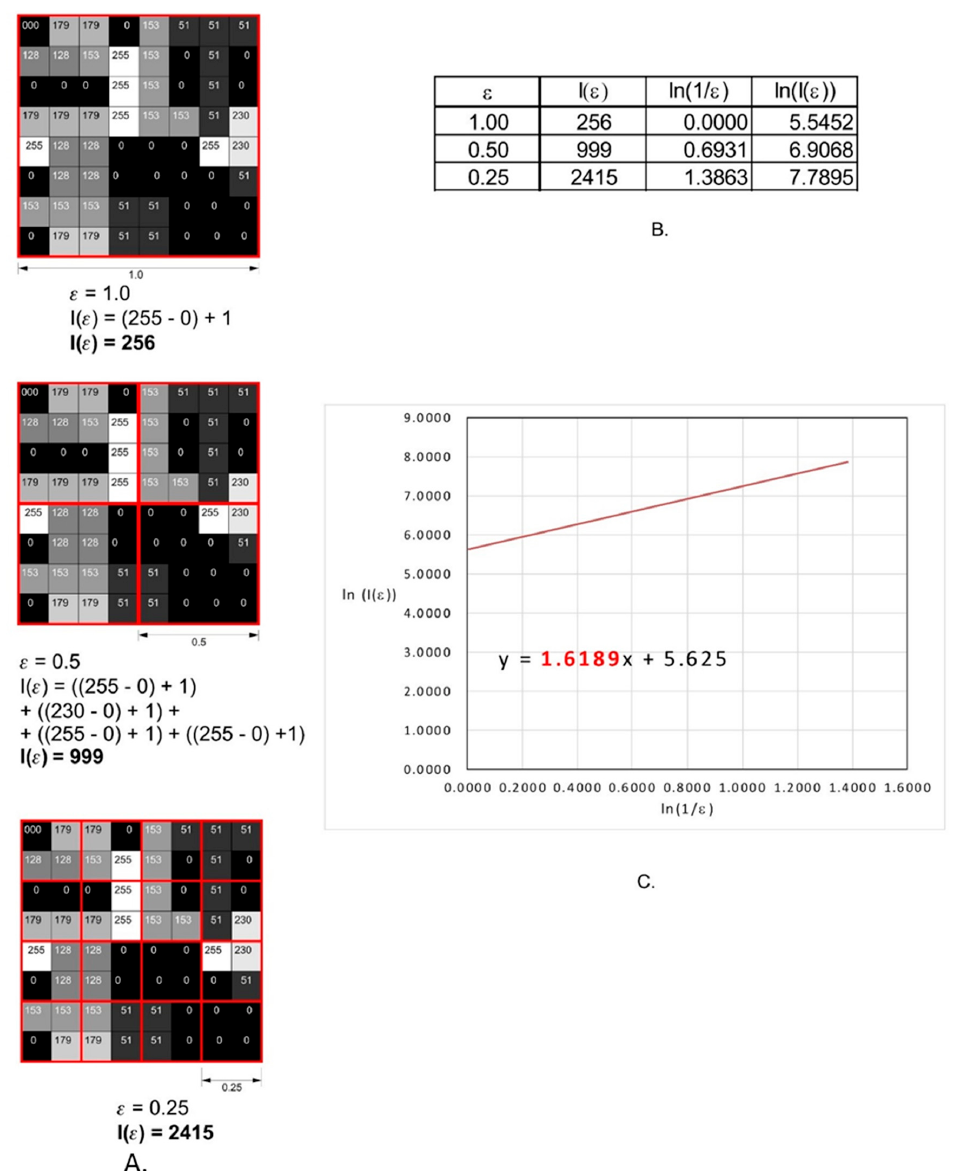
Figure 4. Graphical interpretation of the intensity difference algorithm of the fractal dimension calculation. ( A ) An example of a grayscale 8-bit image (8 × 8 pixels), the numbers in squares represent the intensity level of each pixel: 0, black, 255, white. The red squares represent the scale, ε . ( B ) The values of the intensity difference for each step of scale reduction ( ε ). ( C ) A straight line drawn through the points from table B on the x–y chart in a natural logarithm scale. The slope factor of this straight line is a value fractal dimension counted using intense difference